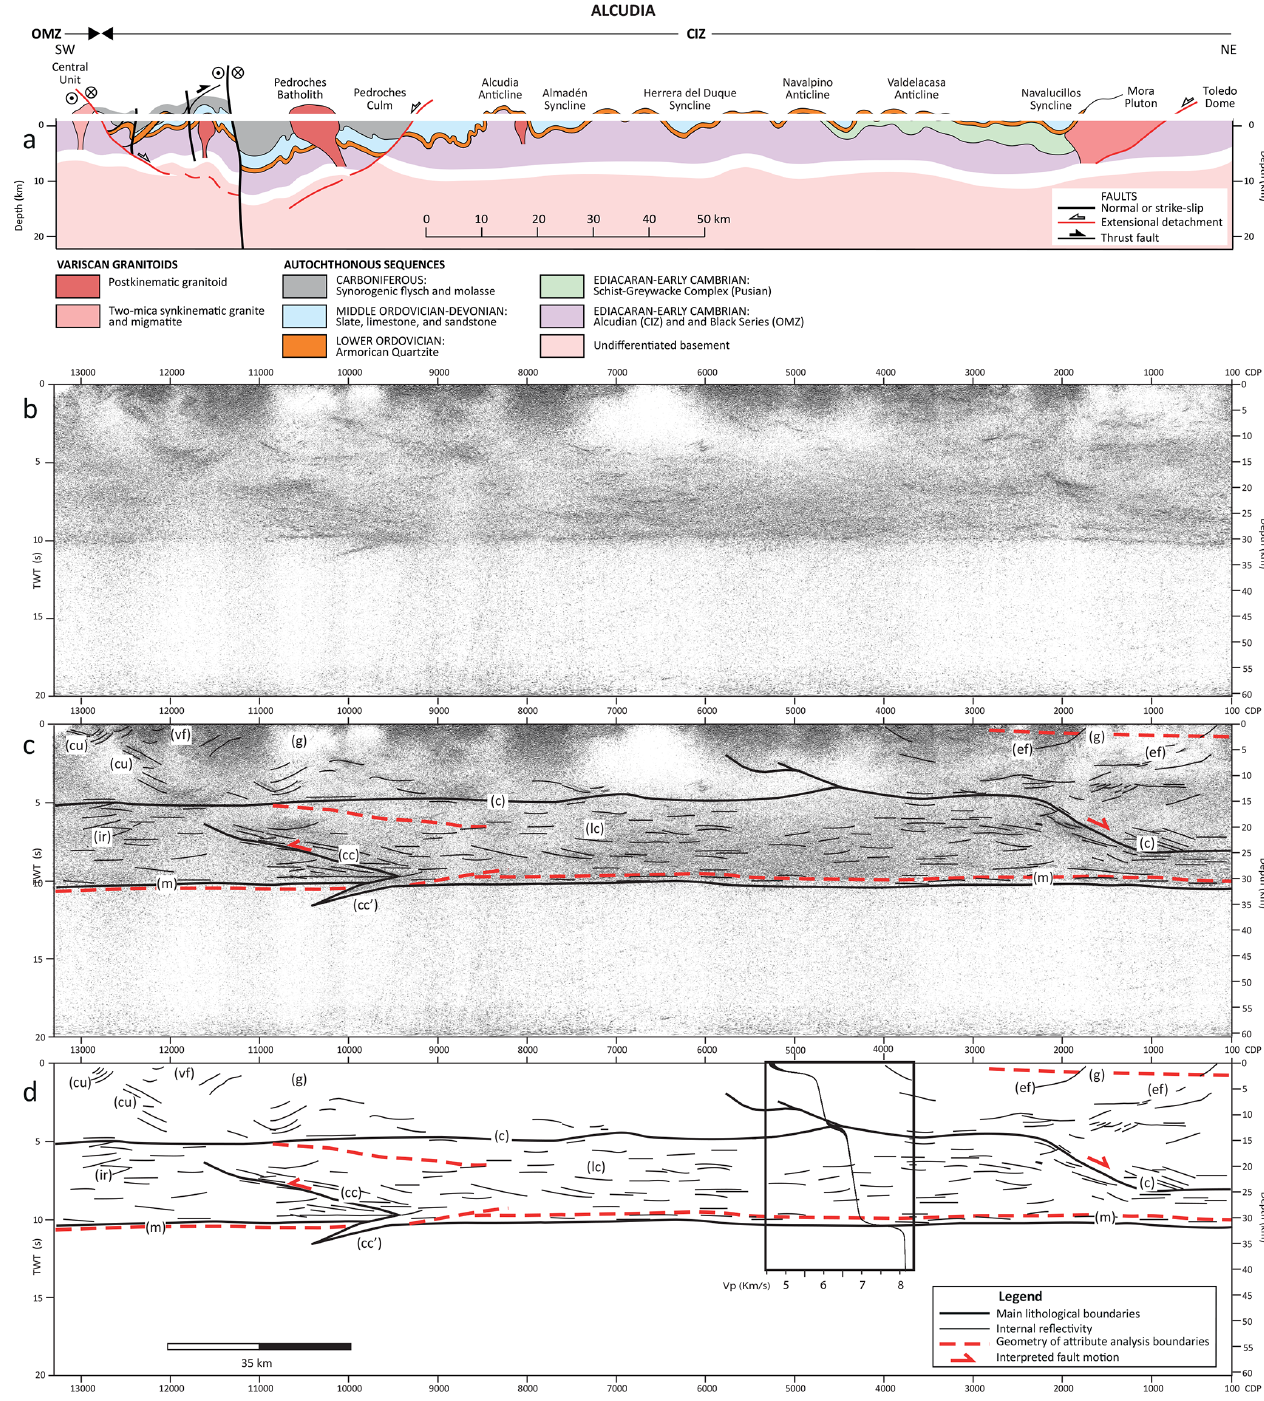
Figure 7. Cross section (a) modified from Martínez Poyatos et al. (2012) and the depth-converted time-migrated section ( v = 6200m/s) of the NI seismic profile ALCUDIA (Fig. 1), without (b) and with (c) interpretation. A sketch of the most important features is presented in panel (d) . A 1D velocity profile as modeled from wide-angle data (Palomeras et al., 2021) is overlapped in panel (d) . The abbreviations used in the figure are as follows: CDP is the common depth point, TWT is the two-way travel time, CIZ is the Central Iberian Zone, and OMZ is the Ossa-Morena Zone. The nomenclature for reflections is as follows: (cu) is the central unit, (vf) denotes vertical folds, (g) denotes granites, (ef) denotes extensional features, (c) is the top of the lower crust, (lc) is the lower crust, (cc) and (cc (cid:48) ) denote crocodile structure, and (m) is the Moho. Red dashed lines represent the boundaries provided by chaos and variance attribute analyses. Depth conversion is based on migration